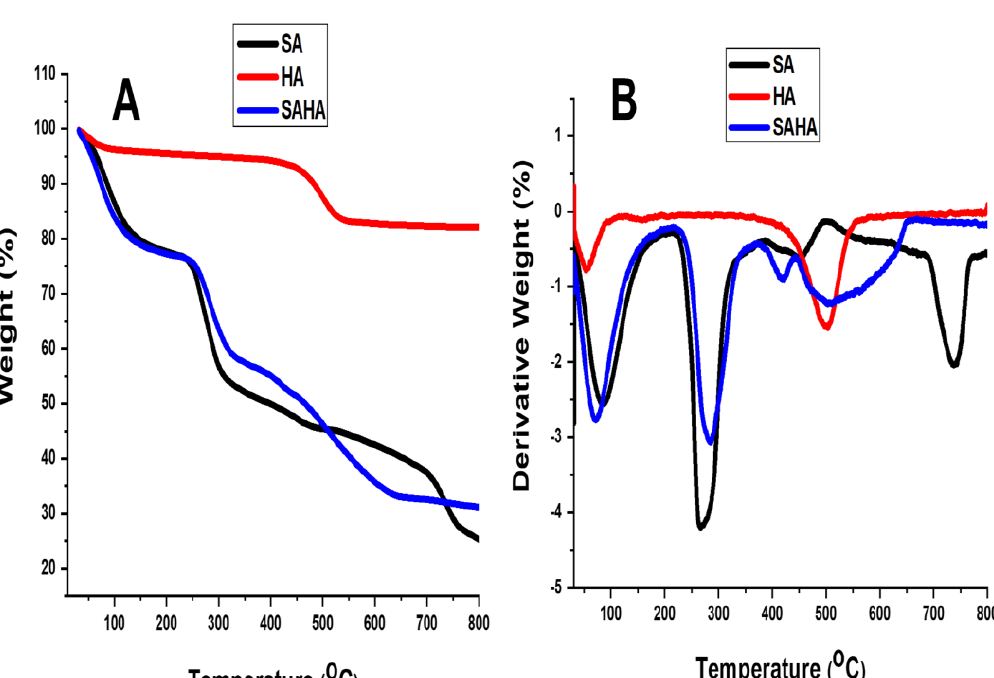
Figure 7. EDX spectra of ( A ) SA and ( B ) SAHA aerogels.